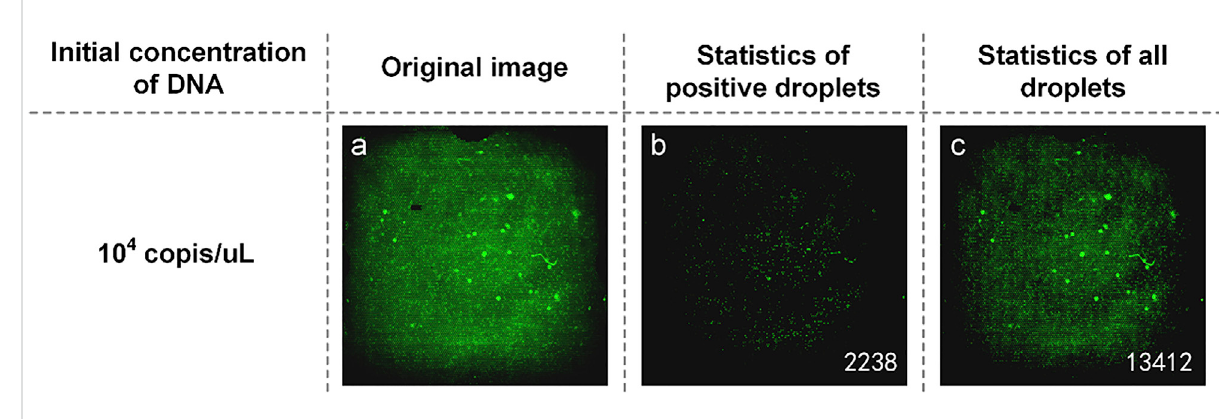
FIGURE 3 (A) Original fl uorescence imageofTP53 DNA; (B) Image processed by software andthenumberof positive droplets; (C) Statistics of all droplets with TP53 DNA.